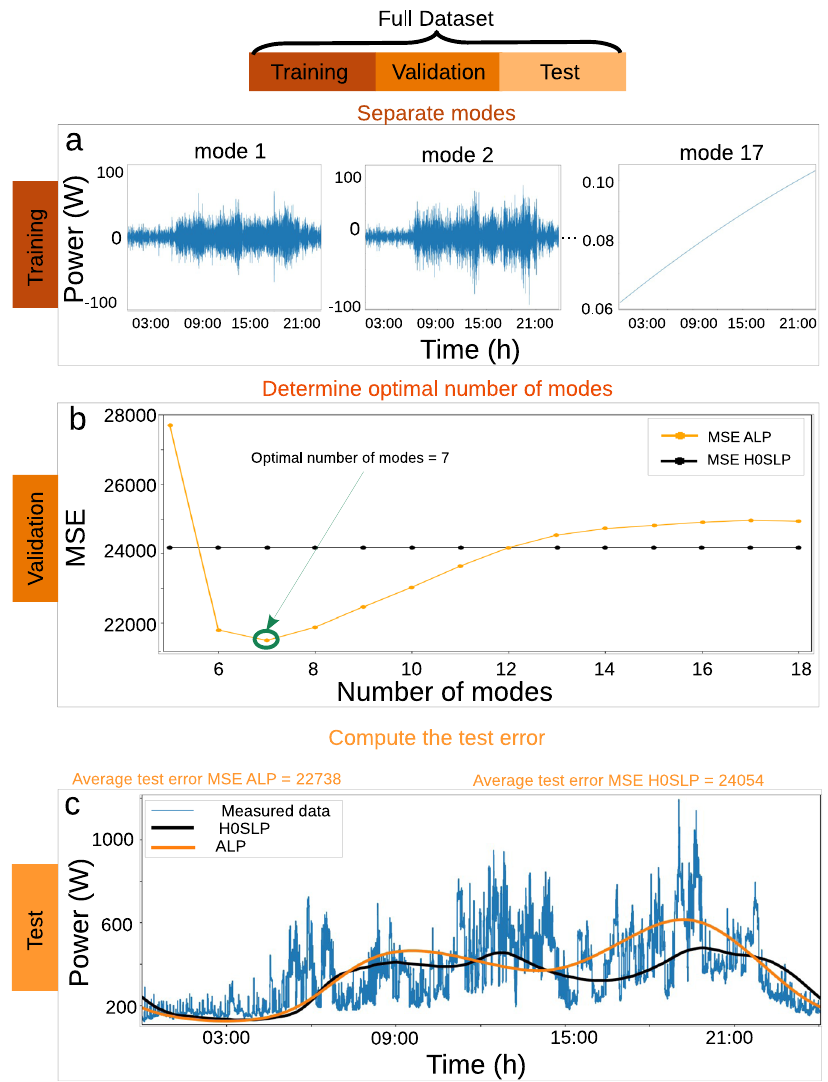
Fig. 3 Training and validation are used to compute the optimal number of modes, avoiding over- and under fi tting. The full dataset is split into training, validation and test datasets (shown at the top of the Figure). a Using the EMD, we decompose the training set into its empirical modes. b Next, the validation set is used to optimise the number of modes, avoiding both under- and over fi tting. Including too many modes over fi ts the data but yields poor results on the test datasets. Vice versa, a model with too few modes under fi ts the data and fails to capture its main trend. Hence, we systematically determine the optimal number of modes by minimising the mean-squared error (MSE). c Finally, using the N optimal , we extract ALP for the test set. Computing the MSE of the ALP obtained for each week demonstrates that the ALP performs better than the H0 SLP, since it tracks the measured energy consumption more closely compared to the H0 SLP. As shown in panel ( c ), the average value of the MSE ALP for all weeks is lower than that of the MSE H0 SLP. For the purpose of clarity only a single day is shown here (28.05), see also Supplementary Note